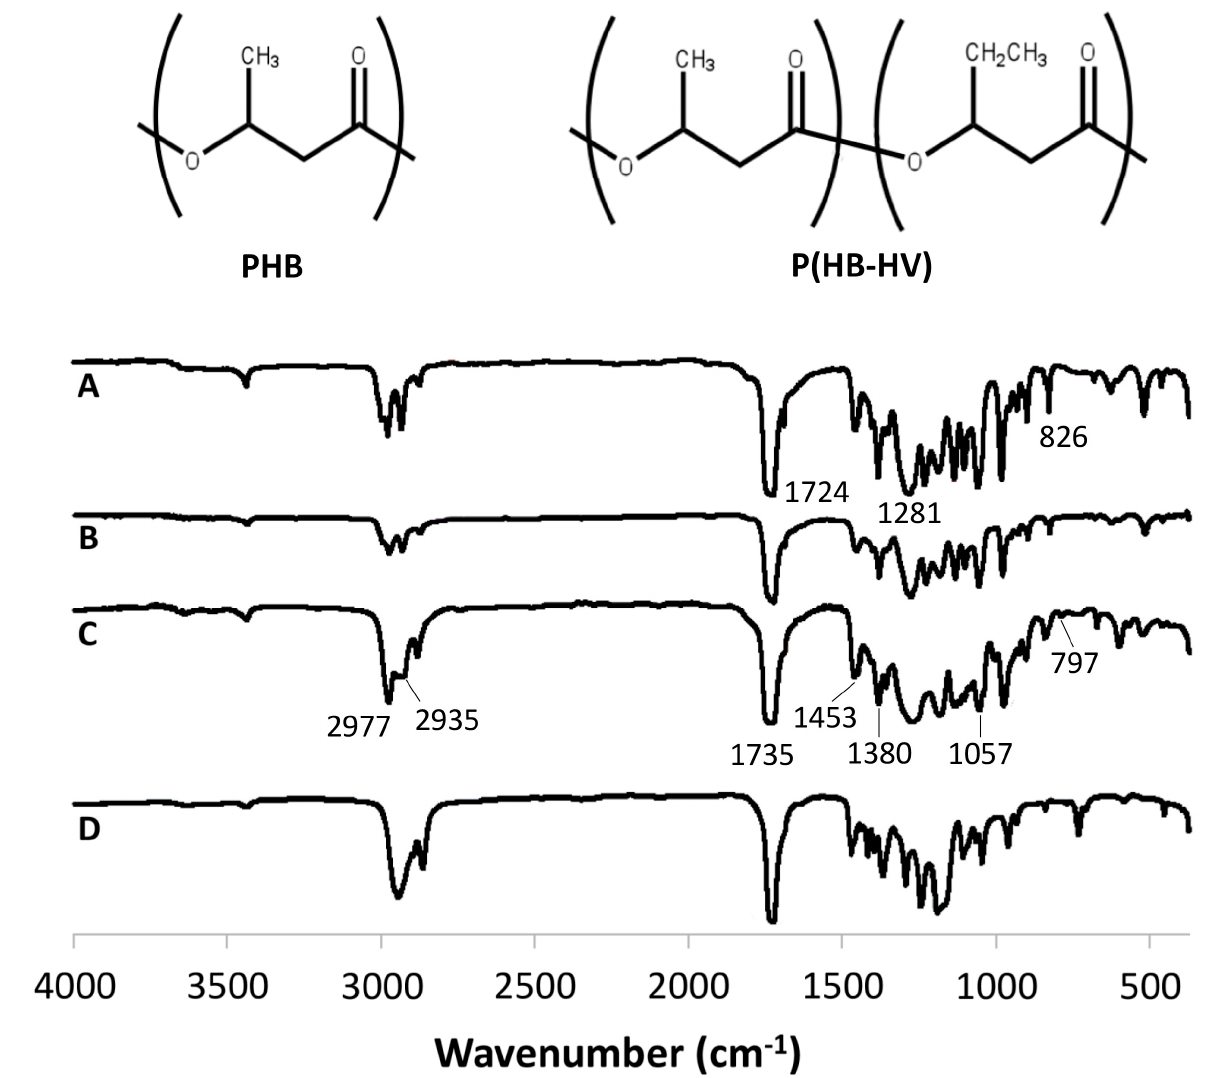
Figure 1. FTIR spectra of the (A) PHB, (B) P(HB-12HV), (C) P(HB-50HV) and (D) PCL polymers.